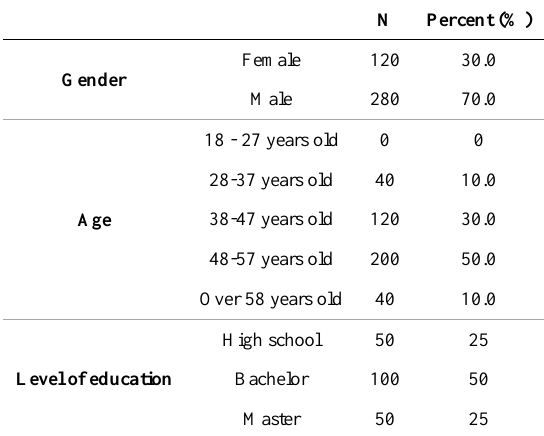
Table 1. Respondent Characteristics; Note: